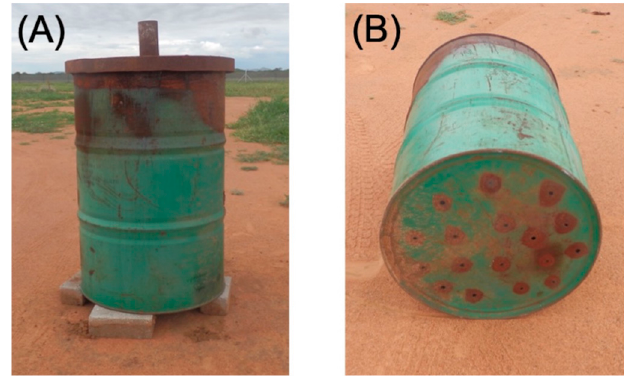
Figure 1. Jatropha fallen leaf biochar production using an oil-drum carbonizer. ( A ) Side view of the carbonizer. An oil drum was placed on top of bricks and covered with a custom-made lid with a funnel. ( B ) Bottom view of the carbonizer. Several ventilation holes were made in the bottom of the oil drum.